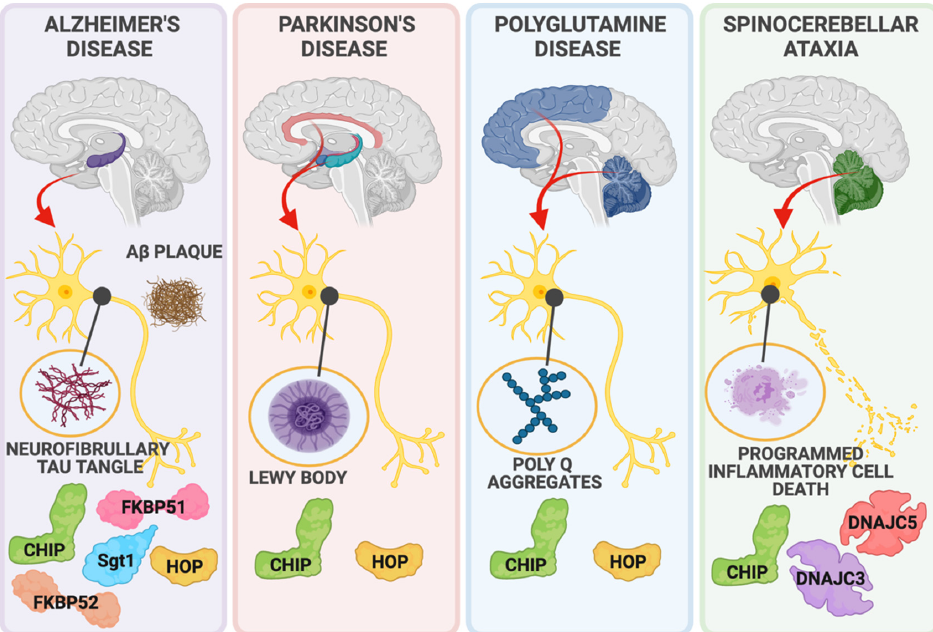
Figure 2. Co-chaperones and neurodegenerative disease . The dysfunction of numerous co-chaperones contributes to neurodegenerative disease pathologies found throughout the brain. HSP70 and HSP90 co-chaperones including CHIP, HOP, FKBP51, FKBP52, and STG1 interact with proteins and aggerates associated with Alzheimer’s disease (Tau, Amyloid-Beta), Parkinson’s (Alpha-synuclein, Lewy Bodies), and Polyglutamine disease (Poly Q aggregates). The co-chaperones DNAJC3, DNAJC5, and CHIP protect against neuronal death in spinocerebellar ataxias.